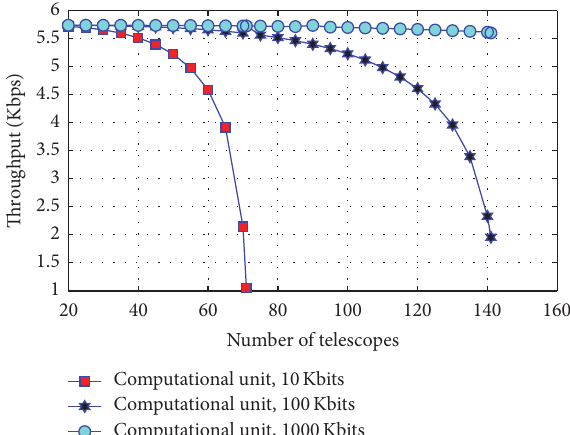
Figure 13: Relationship between terrestrial wireless network throughput and number of